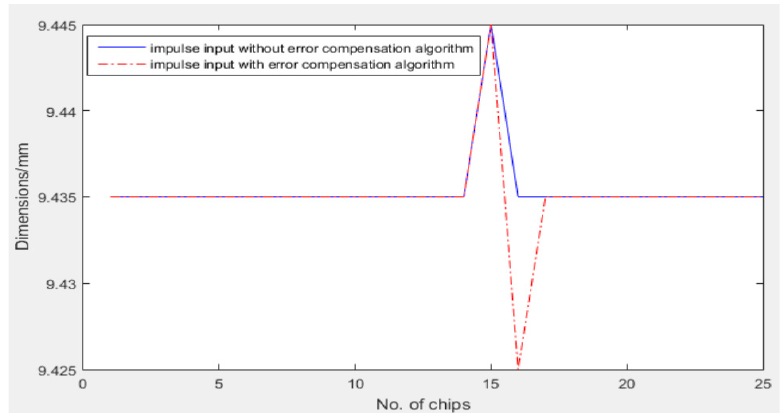
Figure 6. Impulse response of dimension compensation system.